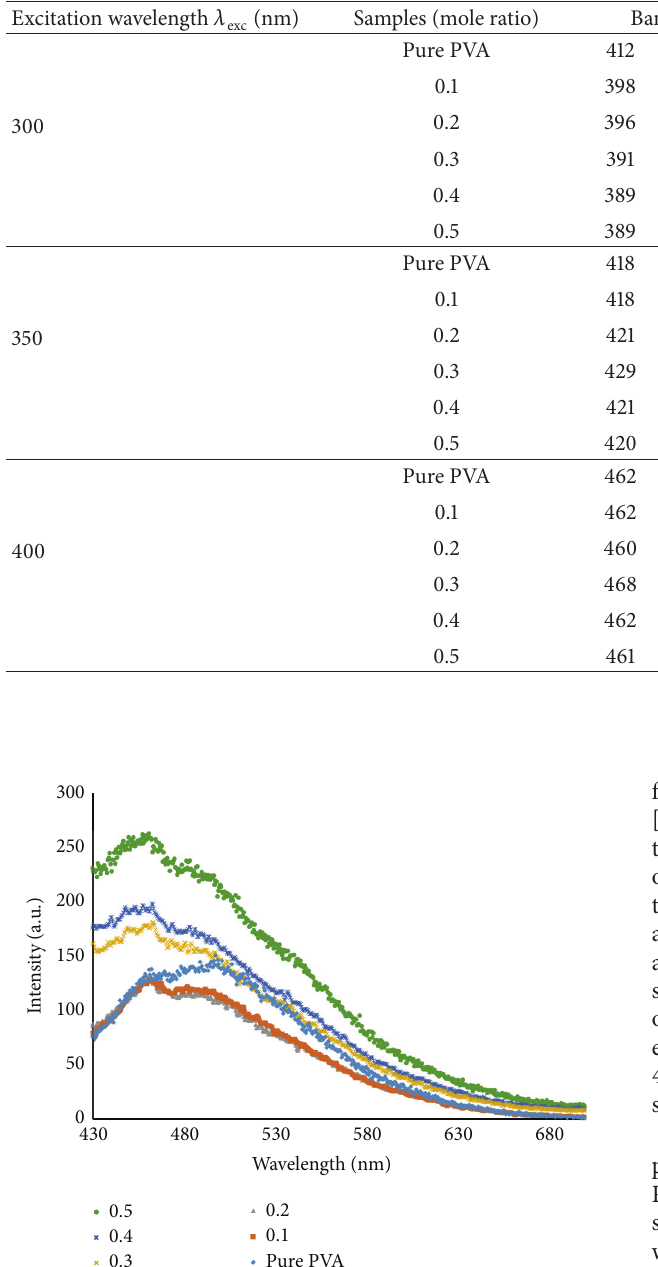
Table 2: Photoluminescence data for pure PVA and PPVA with five mole ratios (0.1, 0.2, 0.3, 0.4, and 0.5) at three excitation wavelengths (300, 350, and 400 nm).